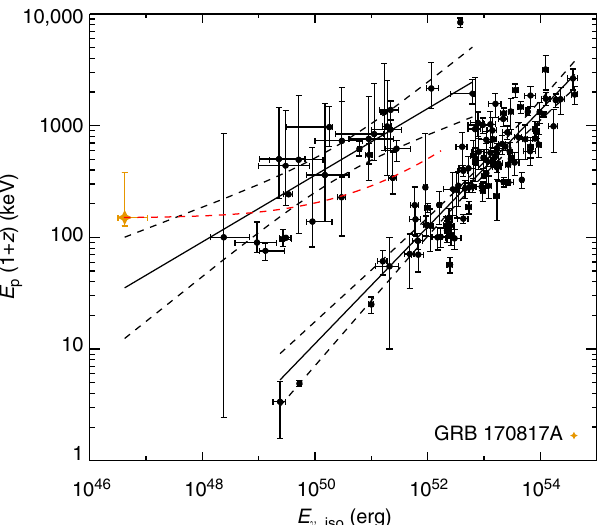
Fig. 3 GRB 170817A in the E p − E iso correlation diagram. The solid lines are the best- fi t correlations: log E p /(1 + z ) = (3.24 ± 0.07) + (0.54 ± 0.04)log ( E iso /10 52 ) for short GRBs, log E p /(1 + z ) = (2.22 ± 0.03) + (0.47 ± 0.03)log ( E iso /10 52 ) for long GRBs. Red dashed line represents GRB 170817A position if it were in different redshifts ranging from 0.009 to 3. All error